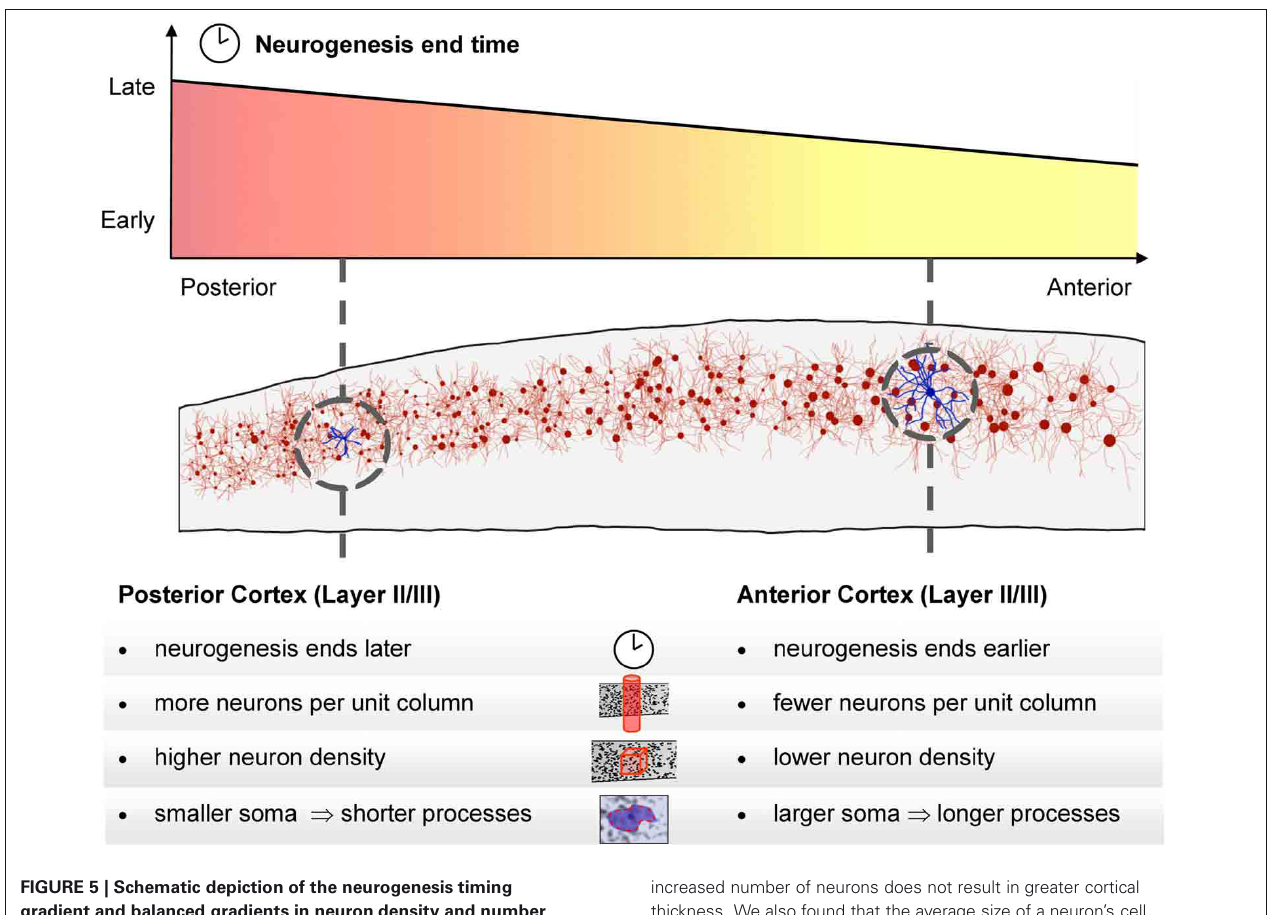
FIGURE 5 | Schematic depiction of the neurogenesis timing gradient and balanced gradients in neuron density and number per unit column. In posterior regions neurogenesis continues for longer, resulting in a higher total number of neurons in each unit column. Higher neuronal density in those regions means that the